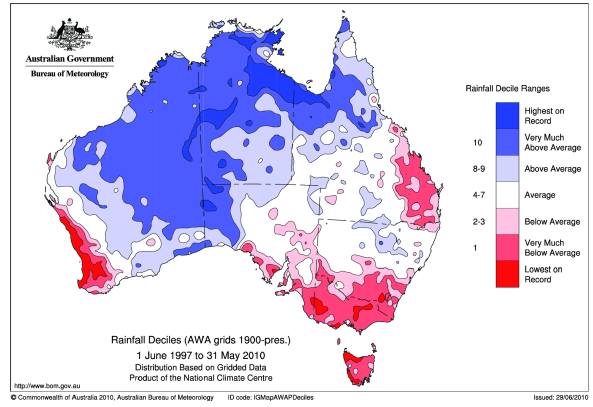
Fig. 3. The 13-yr June 1997 to May 2009 rainfall totals shown as deciles compared to all other 13-yr June to May periods from June 1900 to January 2009. Figure provided by the Australian Bu- reau of Meteorology.